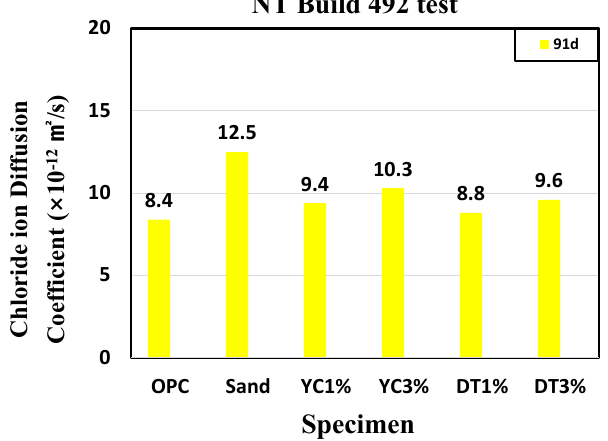
Figure 11. Results of the NT Build 492 test (91 d).